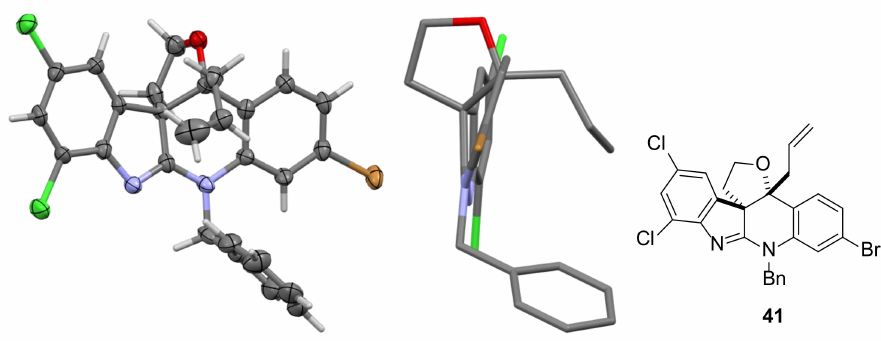
Figure 2. Two views of the X-ray crystal structure of 41 (ellipsoids drawn at the 50 % probability level) used to confirm its